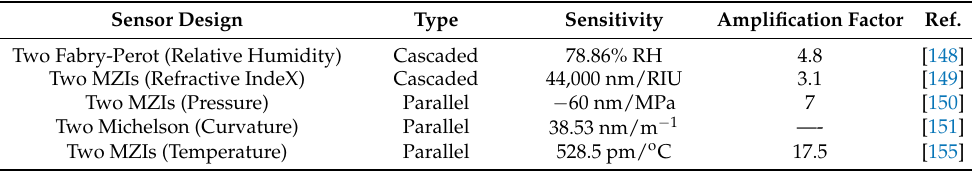
Table 10. Compact type of multiple in-fiber interferometric sensors.